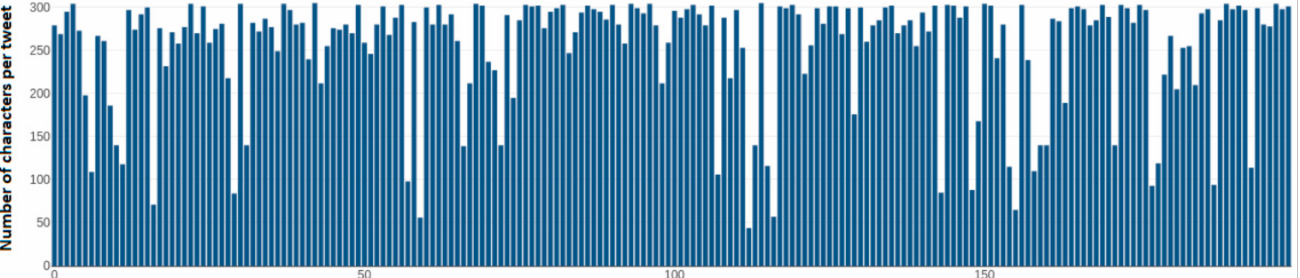
Figure 11. Text length per tweet taken from @kmitsotakis (200 tweet sample).